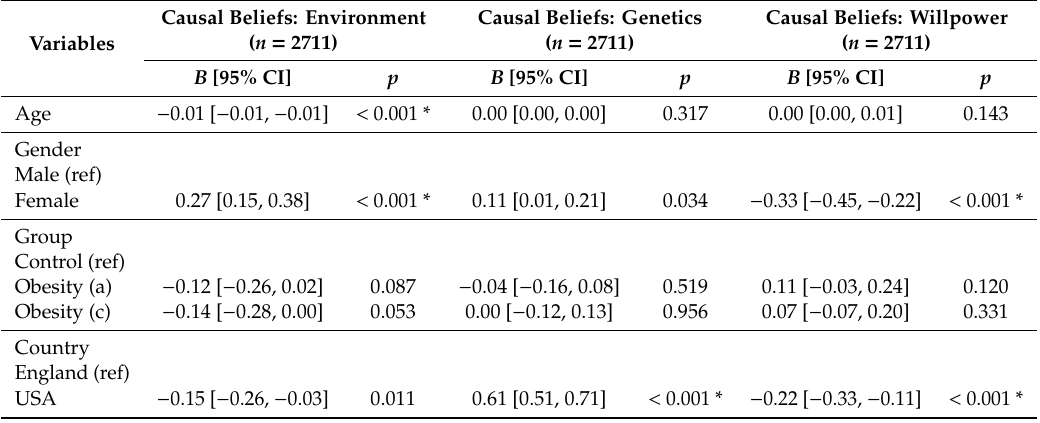
Table 4. Main e ff ects of intervention messages on beliefs about the causes of obesity (Study 2).